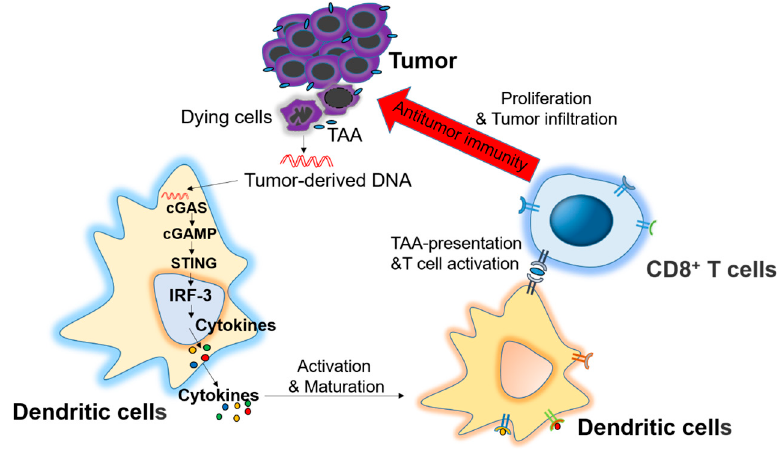
Figure 4. Role of the stimulator of interferon genes (STING) signaling pathway in antitumor immunity. Dying tumor cell-derived DNA is delivered to dendritic cells (DCs) through an unknown mechanism. The DNA is recognized by cytosolic DNA sensor cGAS to produce cGAMP for STING activation and cytokines production, which stimulate the maturation of DCs and stimulate the cross-presentation of tumor associated antigens (TAA) to CD8 + T cells, which exhibit an antitumor immunity after proliferation and infiltration into tumor microenvironment.